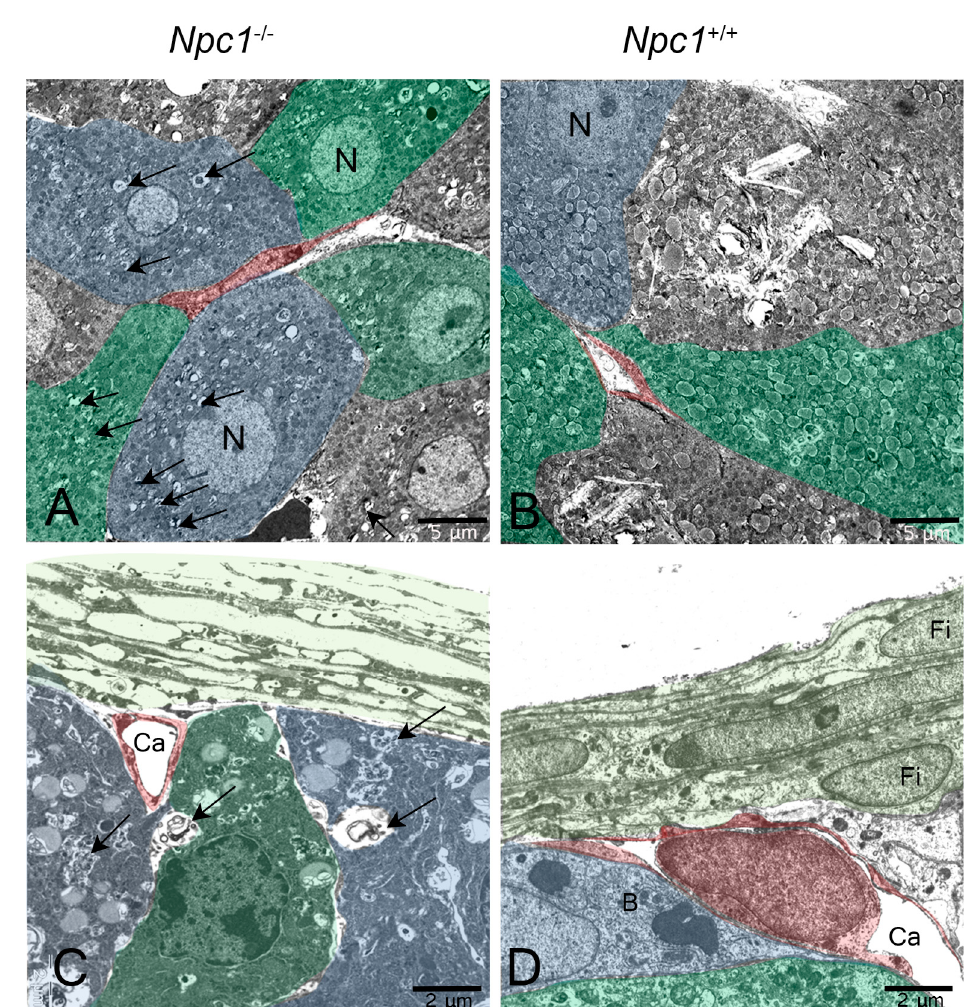
Figure 19. Transmission electron micrographs of the adrenal gland of male Npc1 − / − ( A , C ) and Npc1 +/+ ( B , D ) mice. ( A ) Five adjacent adrenocortical cells are grouped around a capillary (red). Numerous myelin-like inclusions are visible (arrows). Secretory vesicles appear normal. N, nucleus. ( B ) In a wild-type animal, adrenocortical cells do not contain such pathologic deposits. ( C ) Subcapsular adrenocortical blastema cells of a mutant animal with many myelin-like deposits, some of which are shed in an enlarged intercellular space. An endothelial cell is colored red. Fibroblasts of the capsule in light green. ( D ) Normal adrenocortical blastema cells (B, green and blue) and an endo- thelial cell (red). Fi, capsule fibroblasts; Ca, capillary.